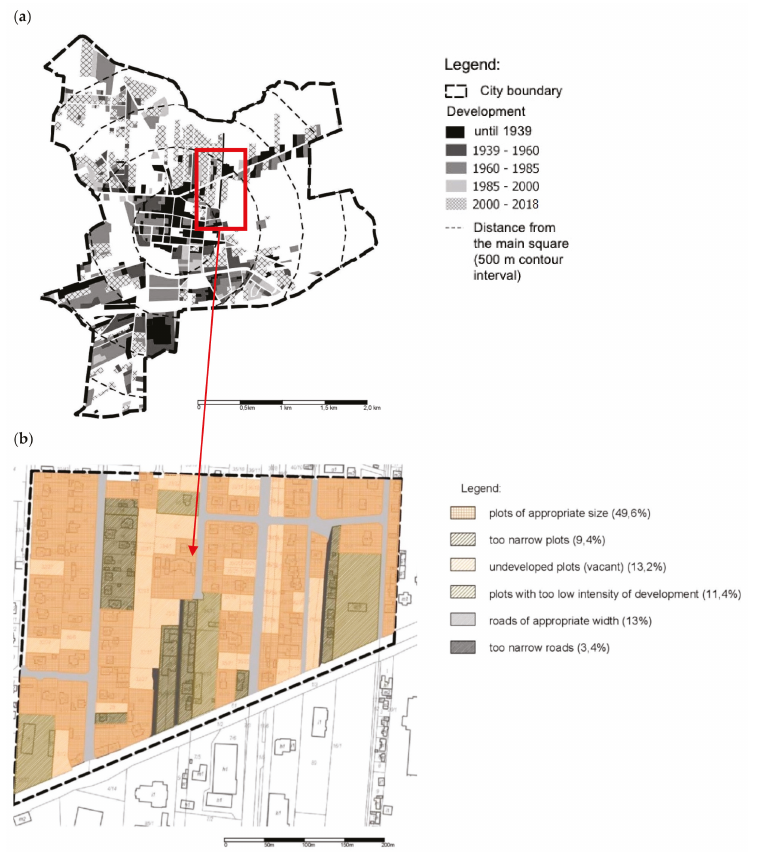
Figure 10. ( a ) Sample stages of dispersion of the city of Błonie; ( b ) A highlighted fragment of the development of a part of the city ( a ), illustrating spatial chaos—‘Tetris’ pattern of development. Source: own